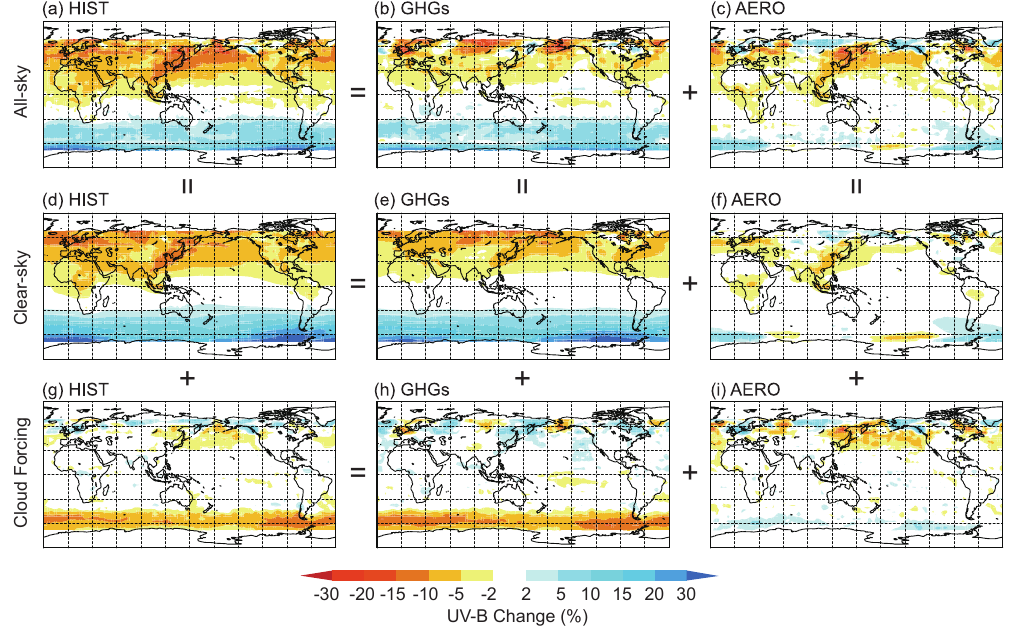
Fig. 3. Relative changes in the annual mean surface all-sky UV-B radiation between the present (1996–2005) and pre-industrial (1850– 1859) periods. As schematically illustrated, the all-sky UV-B changes in the HIST simulation (top left) are approximately decomposed into responses to GHGs forcing (top centre) and aerosol forcing (top right), as well as due to clear-sky processes (middle row) and cloud forcing (bottom